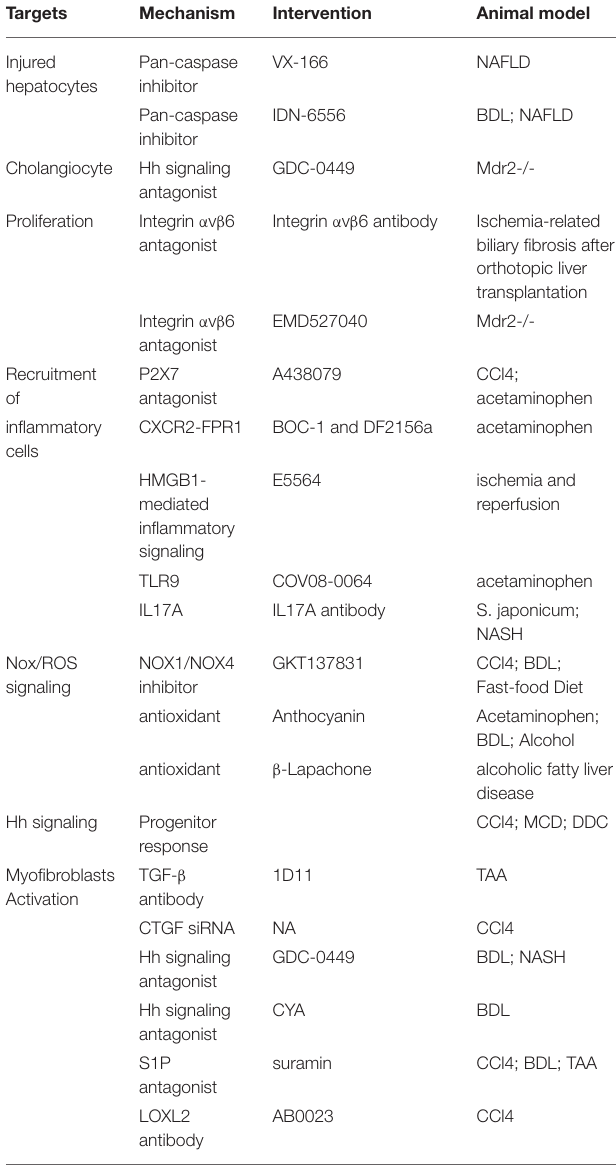
TABLE 1 | Liver injury animal model findings with potential antifibrotic